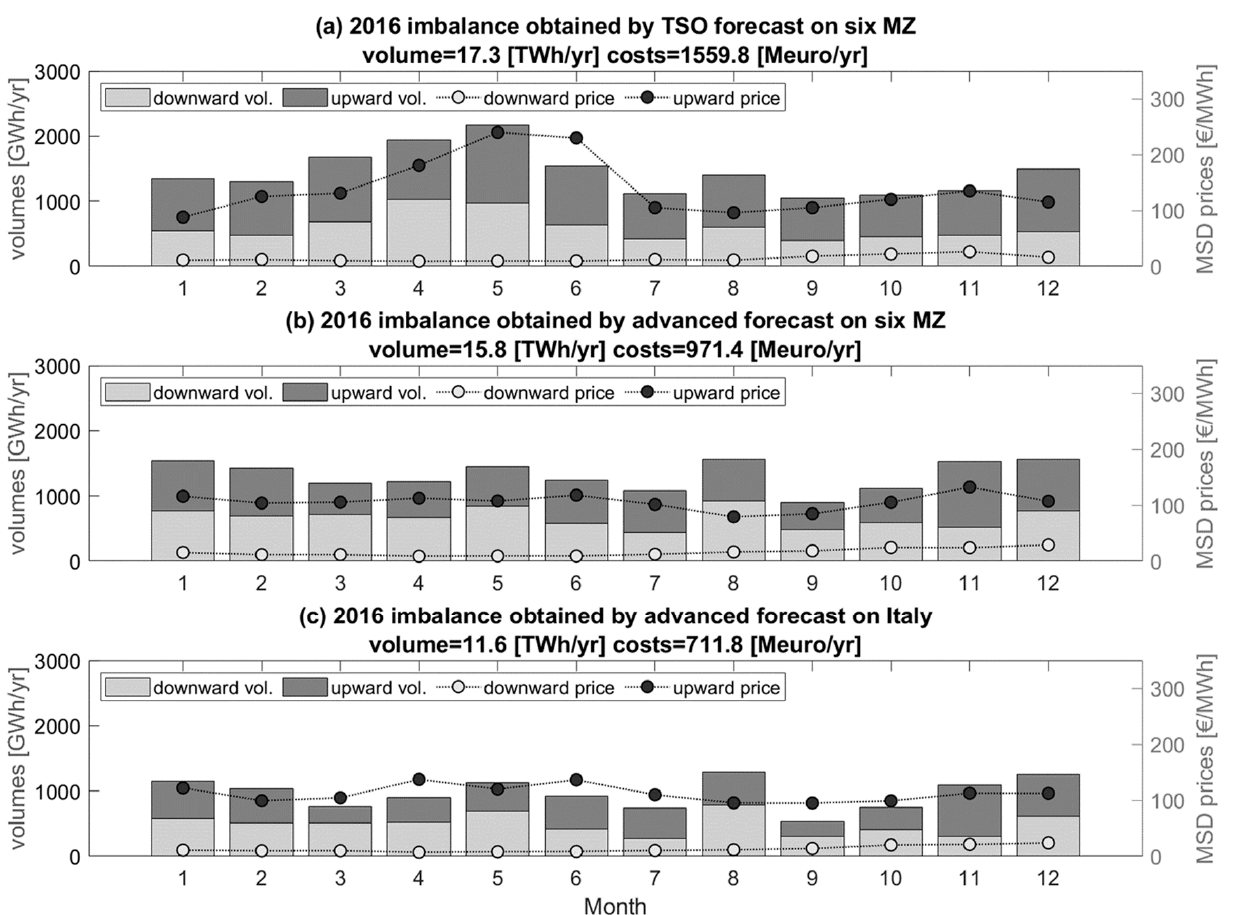
Figure 13. Monthly imbalance volumes and MSD energy prices (weighted with the respective exchanged energy) obtained during 2016 through the TSO forecast methods ( a ), our advanced forecasts in each of the six market zones ( b ) and our advanced forecast aggregated over the entire county ( c ). Note the regional smoothing effect occurring between the middle and bottom plots.